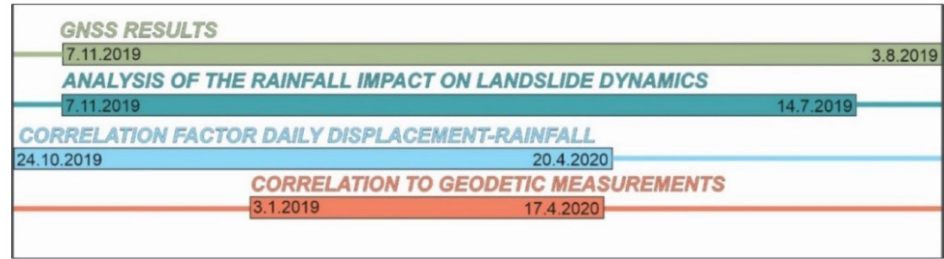
Figure 5. Timeline of the datasets elaborated in this